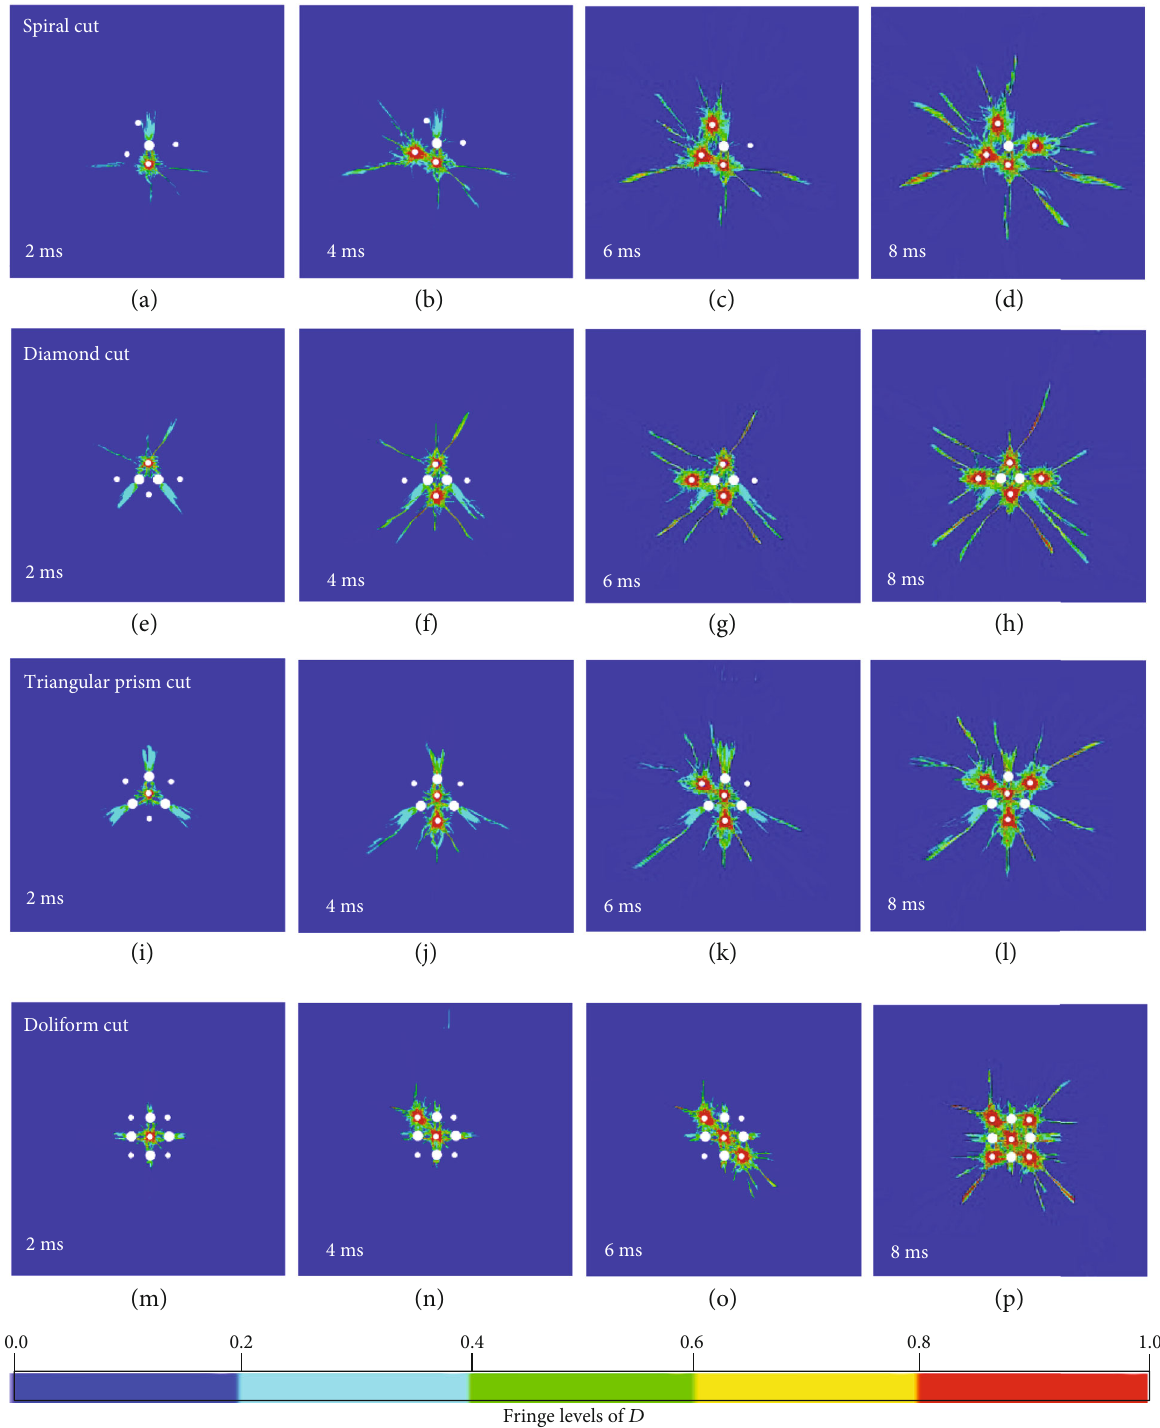
Figure 12: Cut blasting processes of four burn cut models: (a) – (d) spiral cut blasting process, (e) – (h) diamond cut blasting process, (i) – (l) triangular prism cut blasting process, and (m) – (p) doliform cut blasting